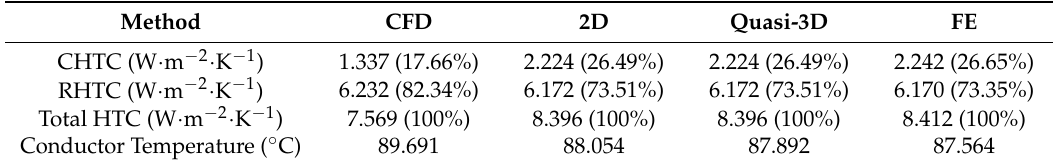
Table 2. Comparison of local heat transfer coefficients (HTCs) and temperatures at the center of the air section (at 667 A).